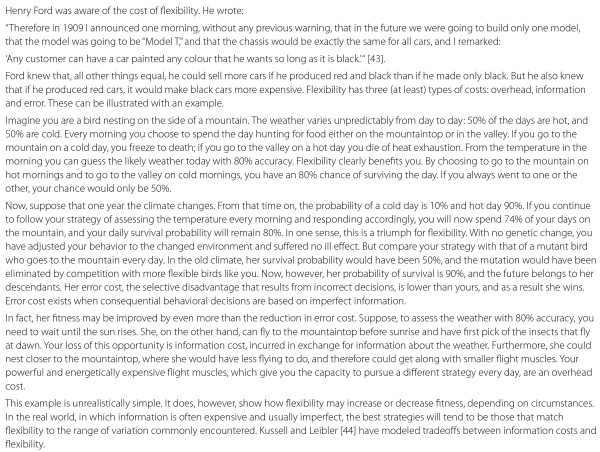
What is behavior?